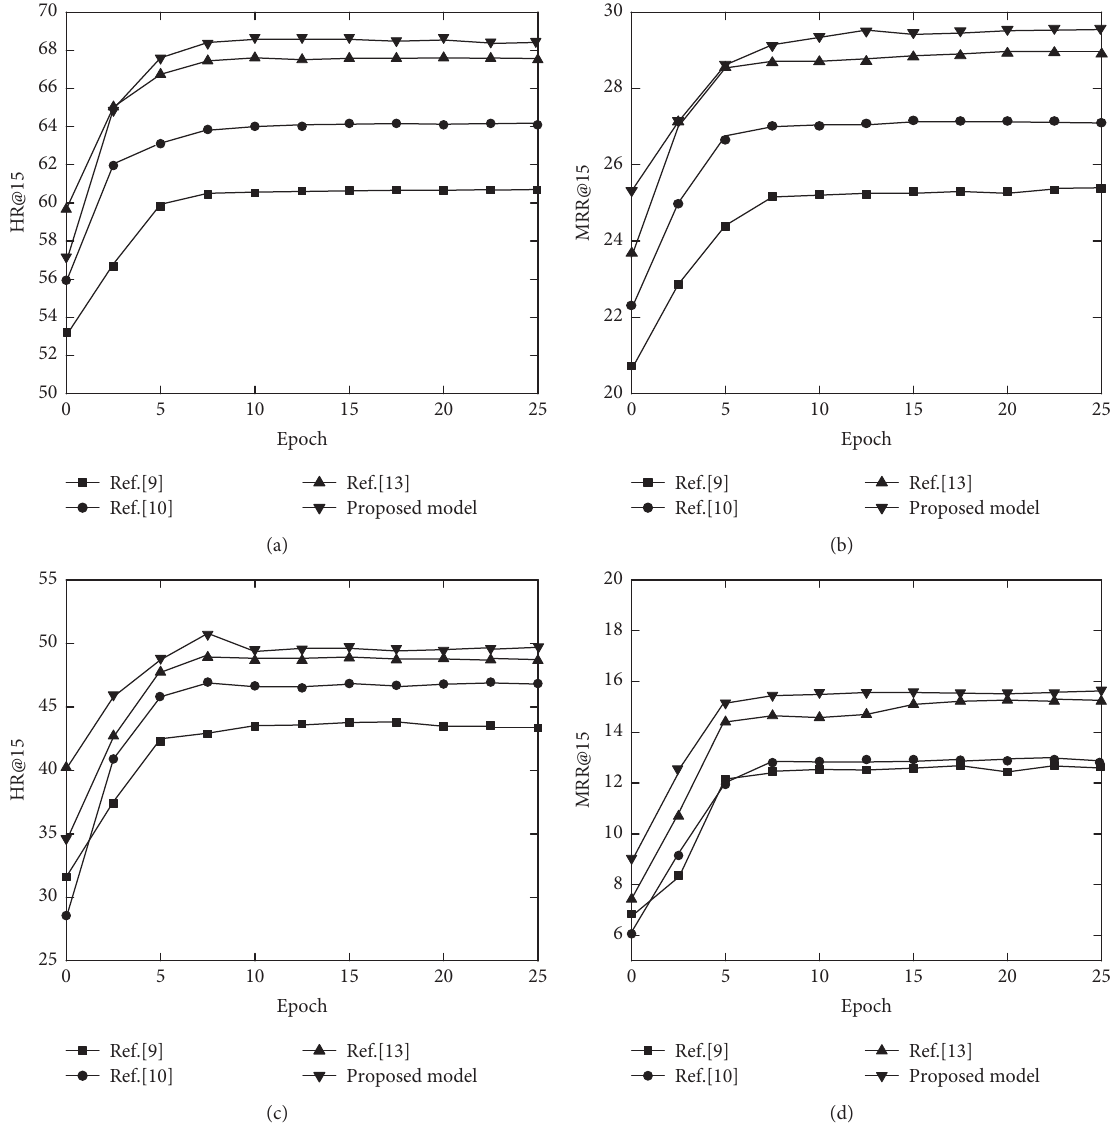
Figure 3: Comparison results of the evaluation indexes of different models. (a) HR@15 comparison results of the JD dataset. (b) MRR@15 comparison results of the JD dataset. (c) HR@15 comparison results of the Tianchi dataset. (d) MRR@15 comparison results of the Tianchi